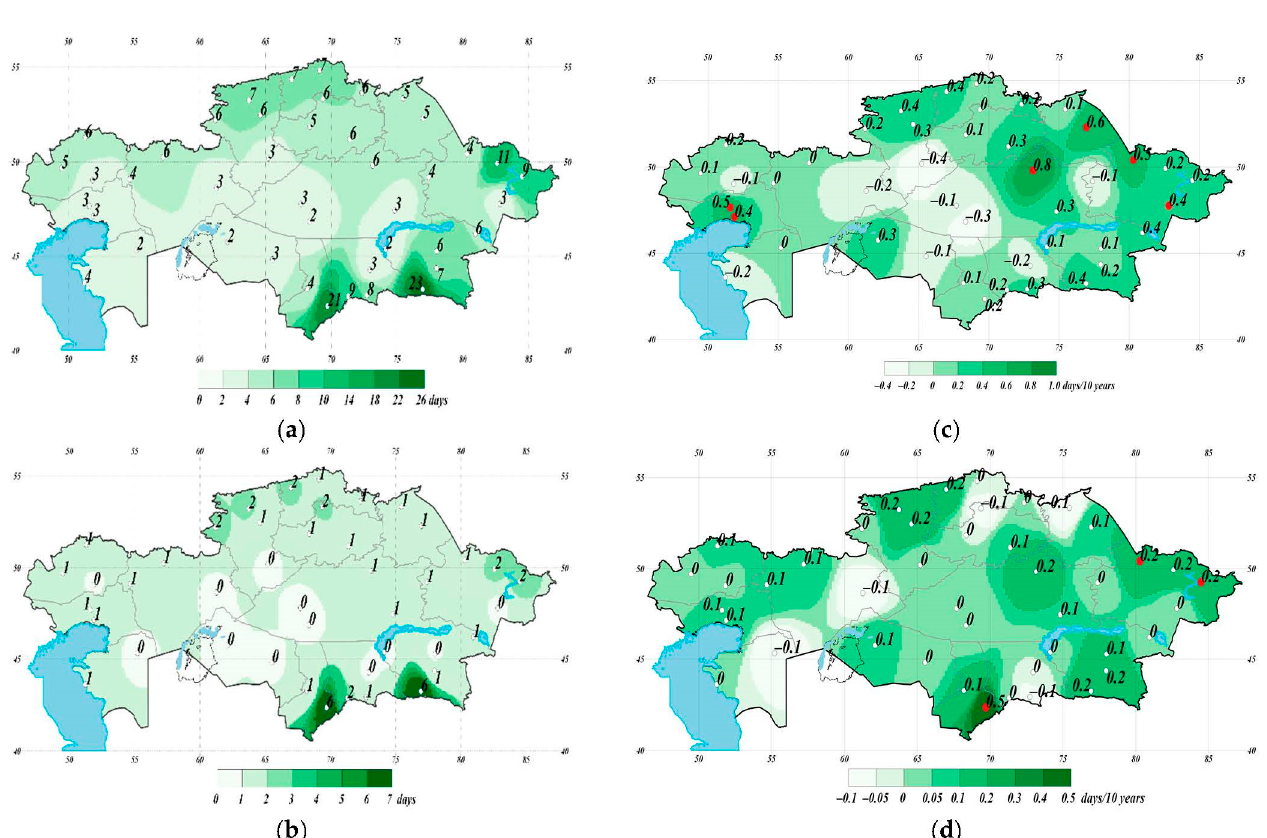
Figure 13. Spatial distribution of indices characterizing the distribution of precipitation amounts more than 10 and 20 mm per day R10mm ( a ), R20mm ( c ), and the heir trends ( b , d ) of these parameters for the period 1971–2020.